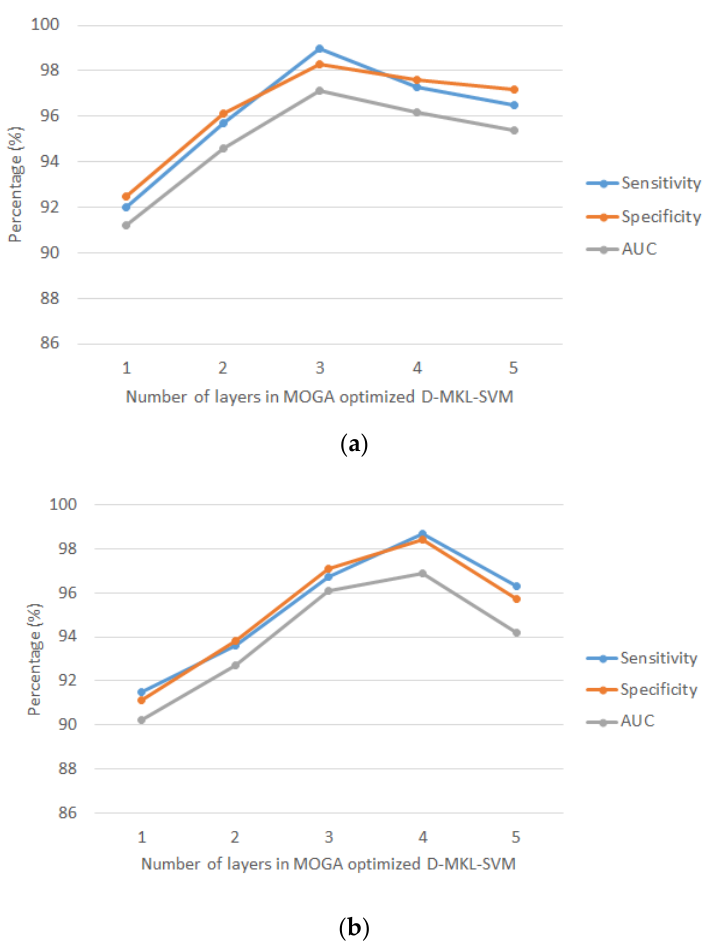
Figure 5. Average sensitivity, specificity and area under the receiver operating characteristic curve (AUC) versus number of layers in MOGA optimized D-MKL-SVM under 10-fold cross-validation: ( a ) driver drowsiness recognition and ( b ) driver stress recognition.